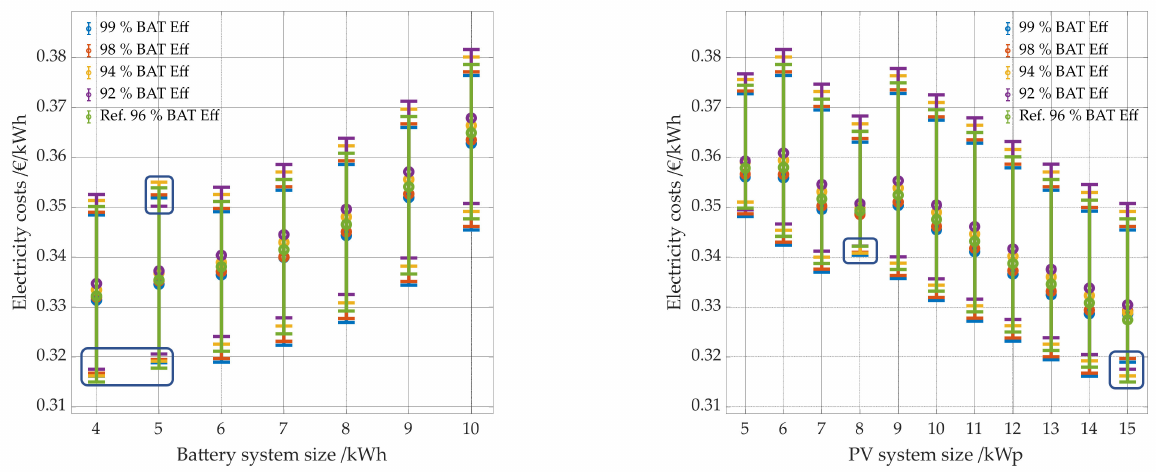
Figure 17. Electricity costs per kWh as a function of battery system size ( left panel) and PV system size ( right panel). Results for the different battery efficiencies are shown in color. The reference case with a battery efficiency of 96% is shown in green.